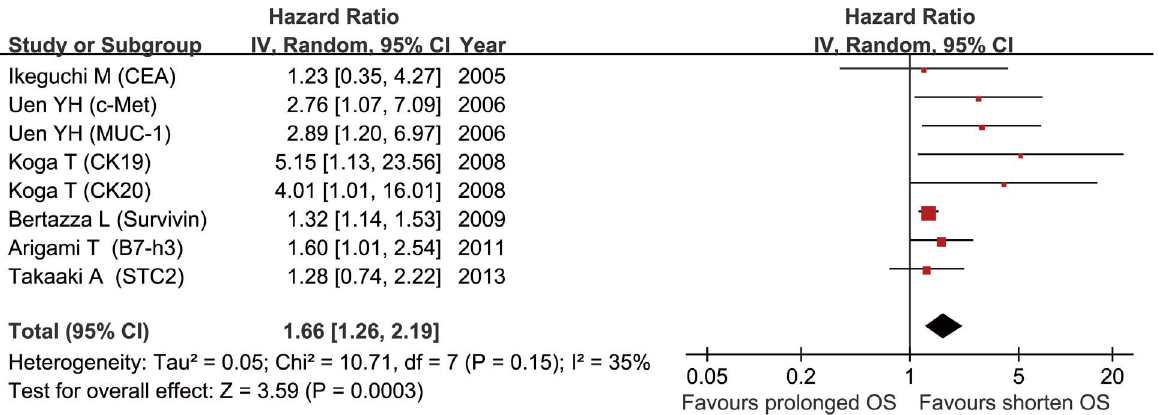
Figure 3. Summary estimates of hazard ratio (HR) for OS. OS, overall survival.